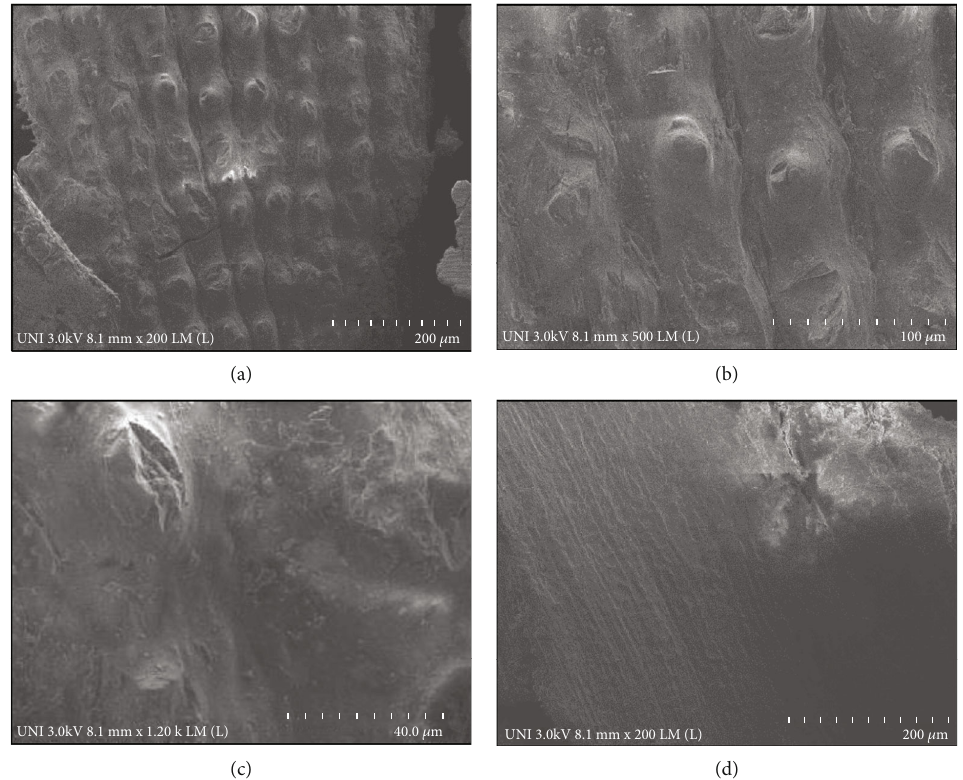
Figure 4: Scanning electron microscopy of the external and internal part of untreated rice husk: (a) external part ( × 200), (b) external part ( × 500), (c) external part ( × 1200), and (d) internal part ( ×